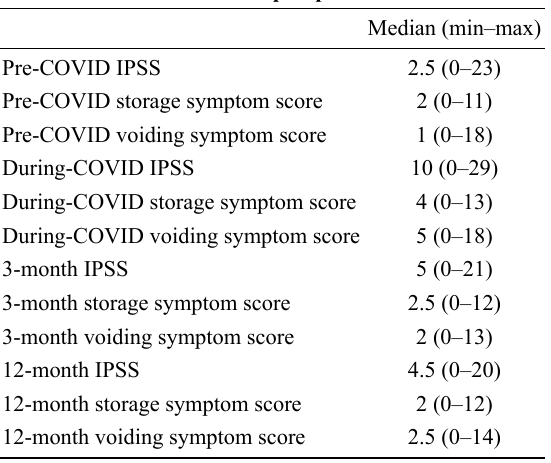
Table 2. IPSS scores before COVID-19, during COVID-19, and follow-up of